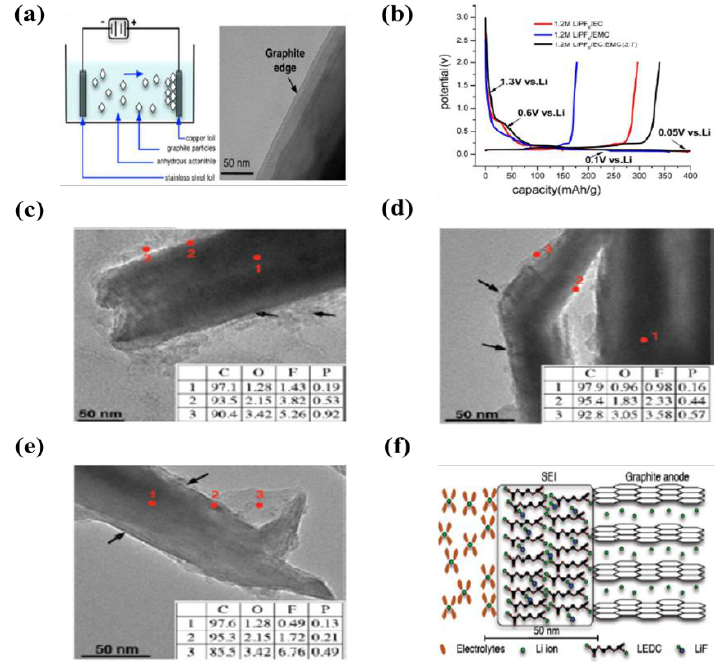
Figure 9. Binder-free graphite prepared by EPD as the anode for Li ion batteries: ( a ) Morphology of binder-free graphite; ( b ) Voltage versus capacity plots with LiPF 6 /EC, LIPF 6 /EMC, and LIPF 6 /EC/EMC (3:7 v / v ) electrolytes. TEM images of binder-free graphite anode cycled to 0.05 V vs. Li/Li + ; ( c ) LiPF 6 /EC; ( d ) LiPF 6 /EMC; ( e ) LiPF 6 /EC/EMC, respectively. The red spots indicate the areas examined